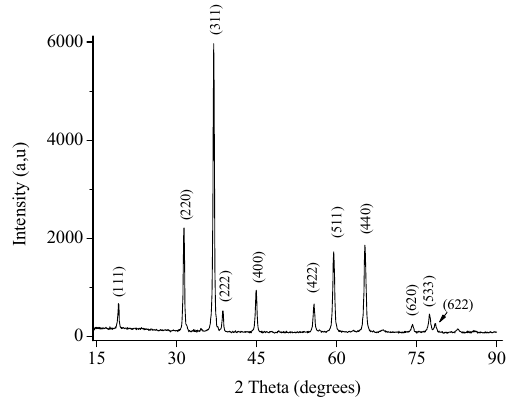
Fig. 2 Adsorption isotherm of HCrO 4− on DZCO2